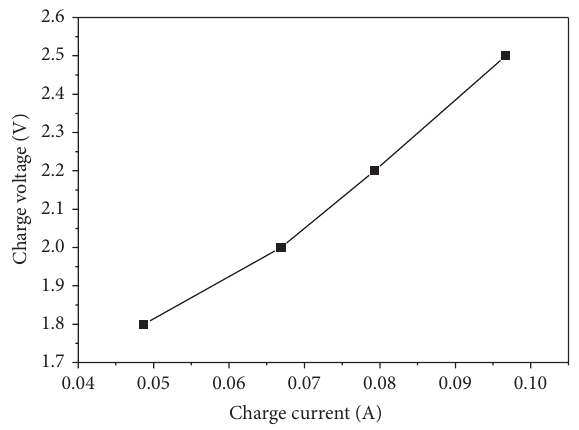
Figure 4: Polarization curves of the battery with quaternized polysulfone membranes at different charge voltage.